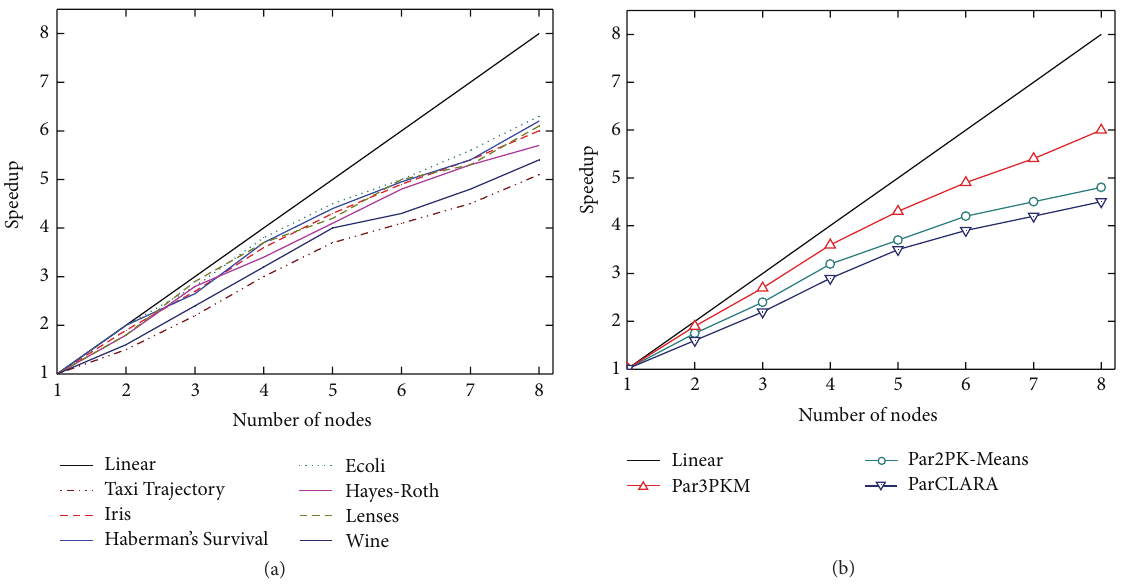
Figure 13: Speedup. (a) Speedup comparison of Par3PKM on different data sets and (b) speedup comparison of Par3PKM, Par2PK-Means, and